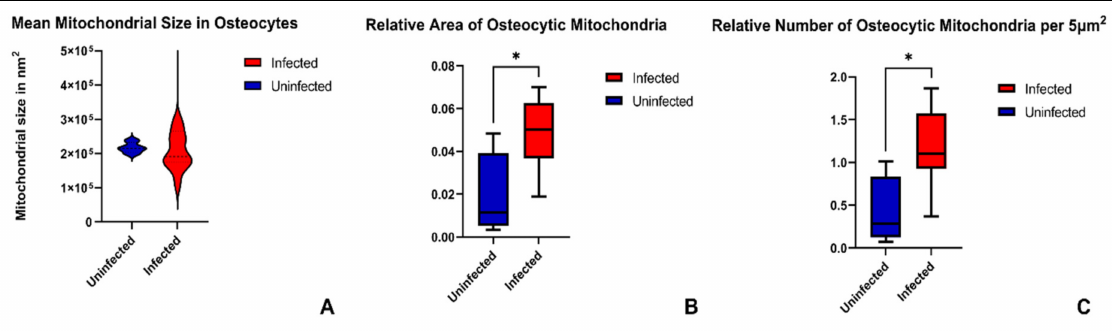
Figure 6. ( A ) Violin plot of mean mitochondrial sizes in osteocytes, measured in nm 2 and showing no measurable difference between groups. ( B ) Box plot of relative cellular area occupied by mitochondria in osteocytes showing a significant increase in the infected group. ( C ) Box plot of number of mitochondria per 5 µ m 2 in osteocytes showing a significant increase in the infected group. * Indicates significant difference at p <